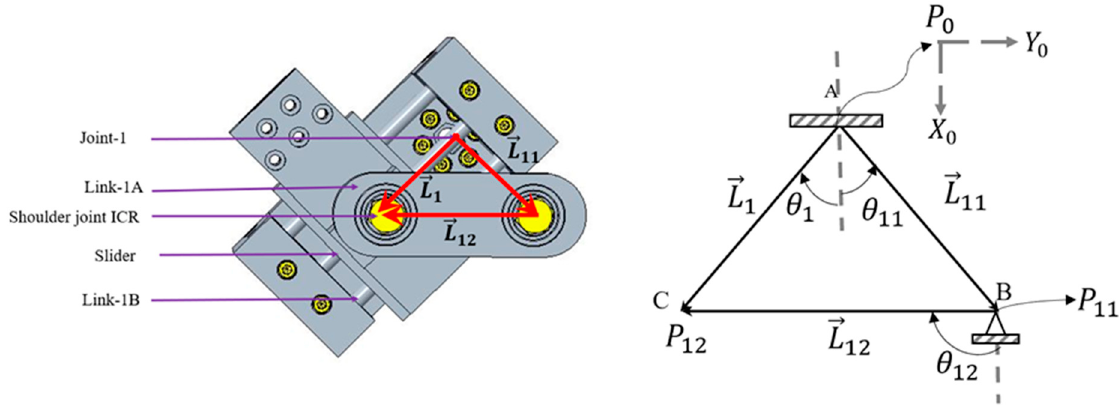
Figure 3. CAD diagram ( left ) and vector formation ( right ) of the frontal mechanism.